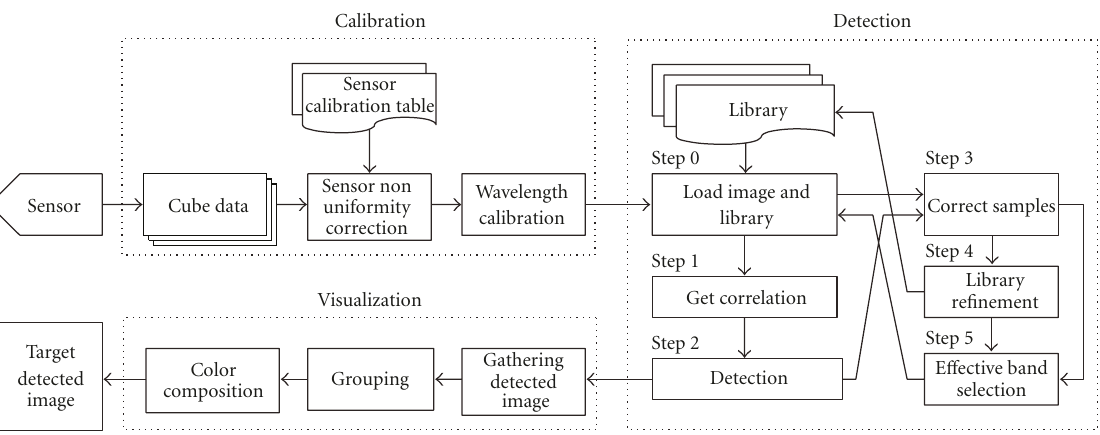
Figure 3: The block diagram of overall hyperspectral processing. A detailed description of steps is explained in Section